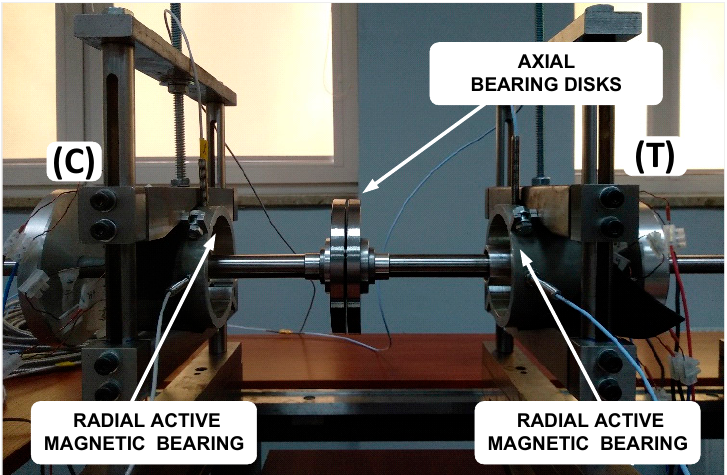
Figure 2. Laboratory stand with the magnetic suspension system of a UAV rotor.